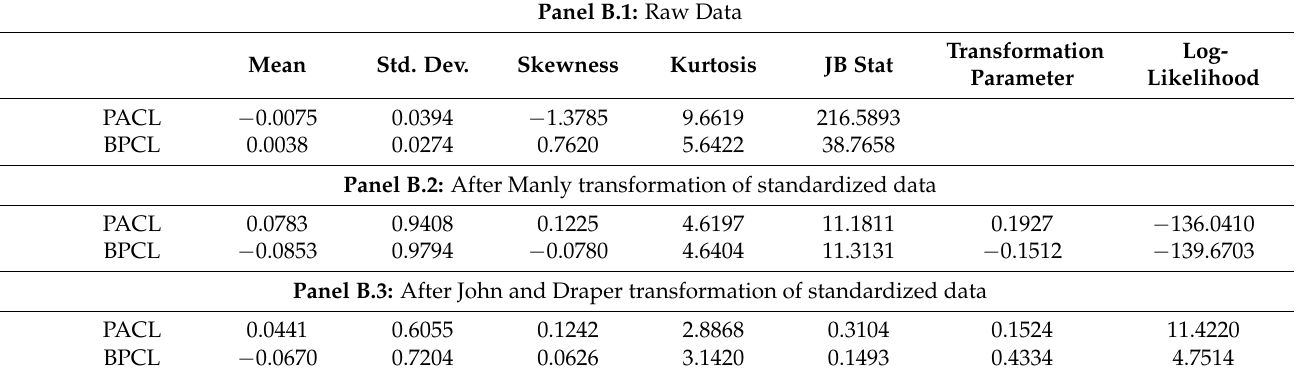
Panel B.3: After John and Draper transformation of standardized data